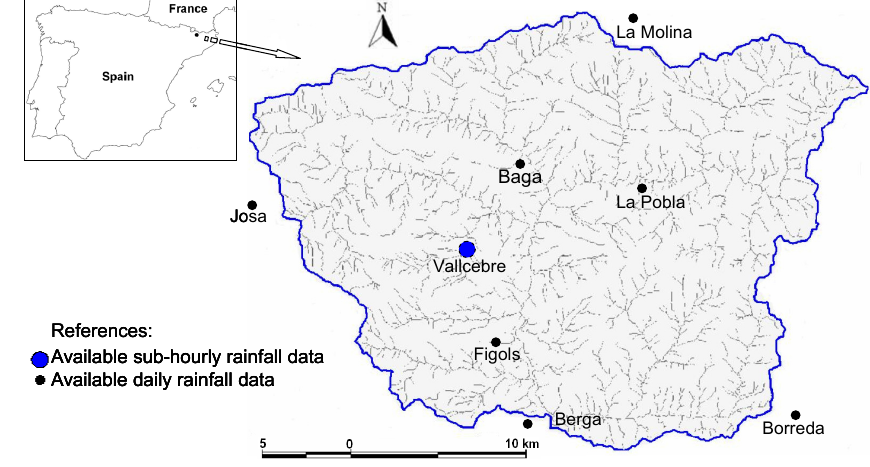
Figure 1. Fig. 1. Study area and location of rainfall stations.